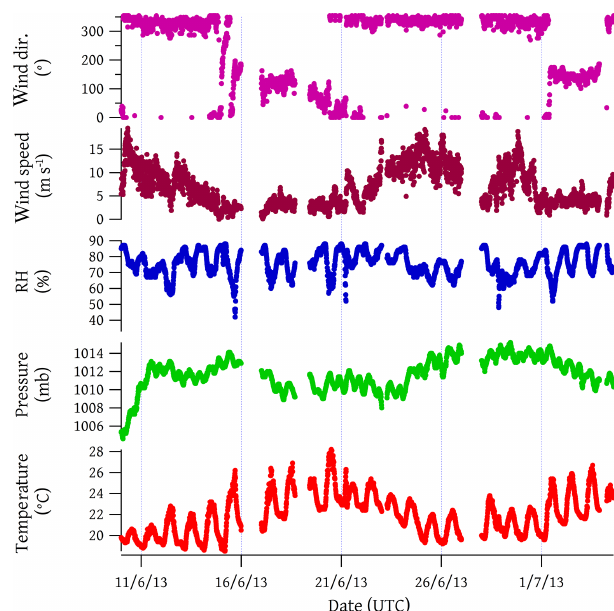
Figure 3. Meteorological conditions (wind direction and speed, rel- ative humidity, pressure and temperature) measured at the Lampe- dusa site during